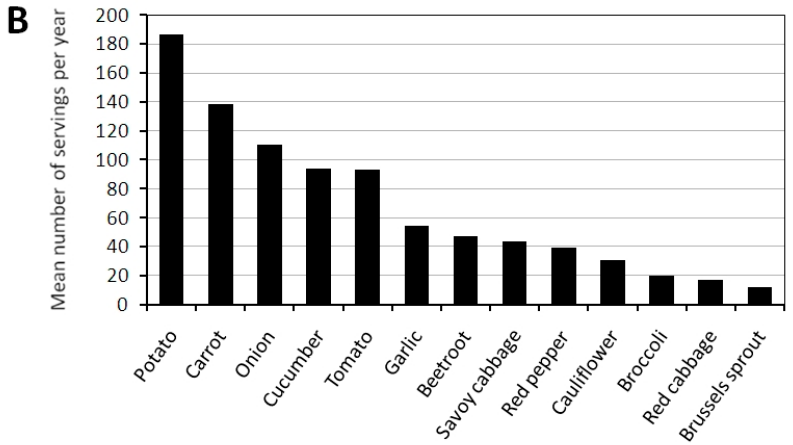
Figure 3. Fruit ( A ) and vegetables ( B ) frequency intake in the hemodialyzed patients’ diet.